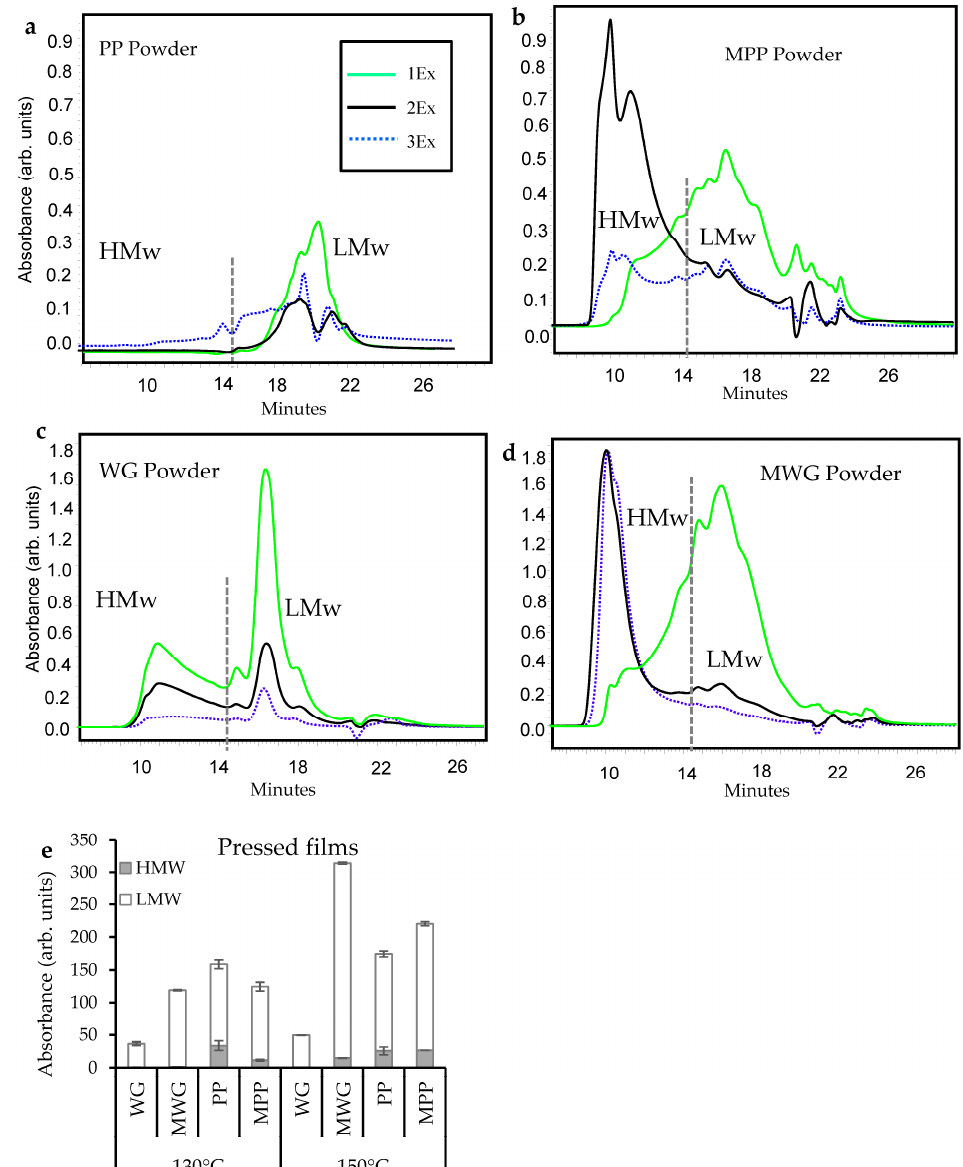
Figure 1. Representative chromatograms of protein molecular size distribution of potato protein powder (PP) ( a ), modified potato protein powder (MPP) ( b ), wheat gluten (WG) ( c ) and modified wheat gluten (MWG) powder ( d ), and the total protein extractability of films from the 3 extractions of non-modified and pH-modified proteins pressed at 130 ° C and 150 ° C ( e ).